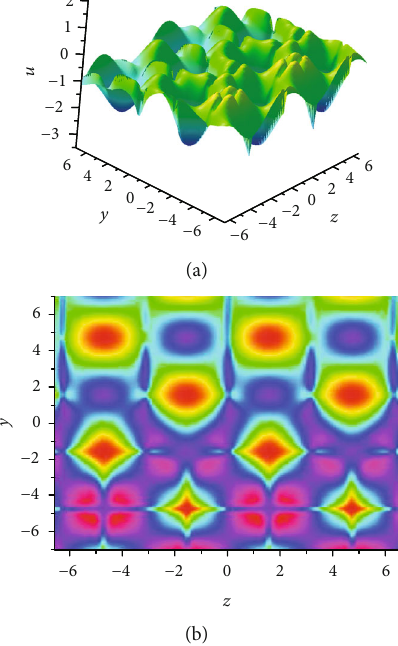
Figure 1: The graph of generalized 1-soliton solution for Equation (4), where x = t = 0 , k 1 = 1 , p ð y , z Þ = cos 2 ð y Þ cos 2 ð z Þ , φ 1 ð y , z Þ = exp ð y Þ sin 2 ð z Þ , and γ ð t , y , z Þ = sin ð y Þ sin ð z Þ . (a) Perspective view of the u in the ð y , z , u Þ space and (b) overhead view of the u .